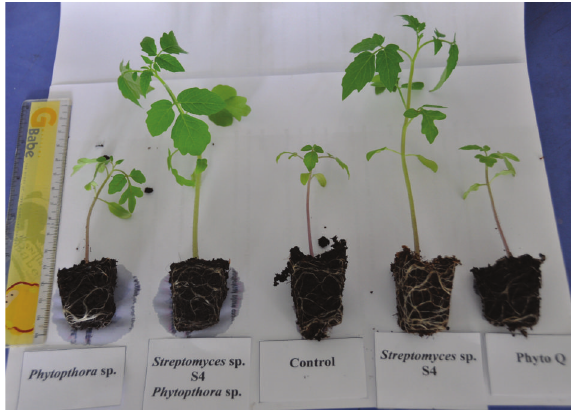
Figure 5: The healthy tomato seedlings grown in peat moss inoculated with Phytophthora infestans and S. rubrolavendulae S4 in di ff erent